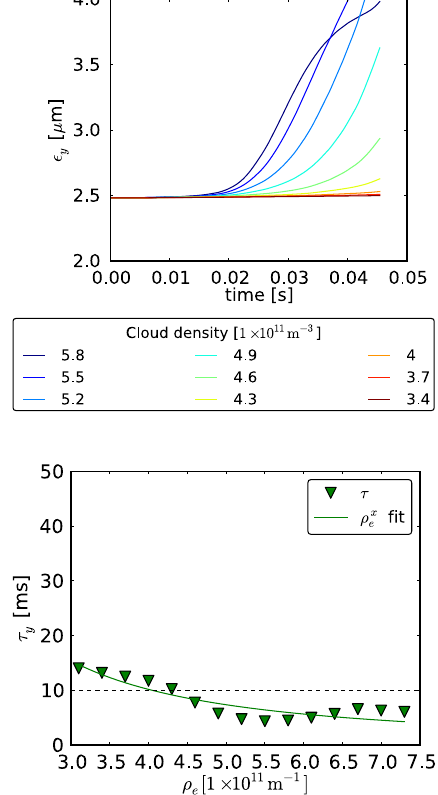
FIG. 15. Top: Emittance evolution for different central cloud densities at an energy of 3.5 TeV, considering a proton beam passing through a straight section. The legend entries indicate the central cloud densities in 1 (cid:2) 10 11 m (cid:1) 3 . Bottom: The cor- responding rise time values with threshold set at 10 ms. curves are plotted on the top graph together with the corresponding rise time values on the bottom graph. The dependency of the rise times versus the central cloud density for this particular case is best approximated by